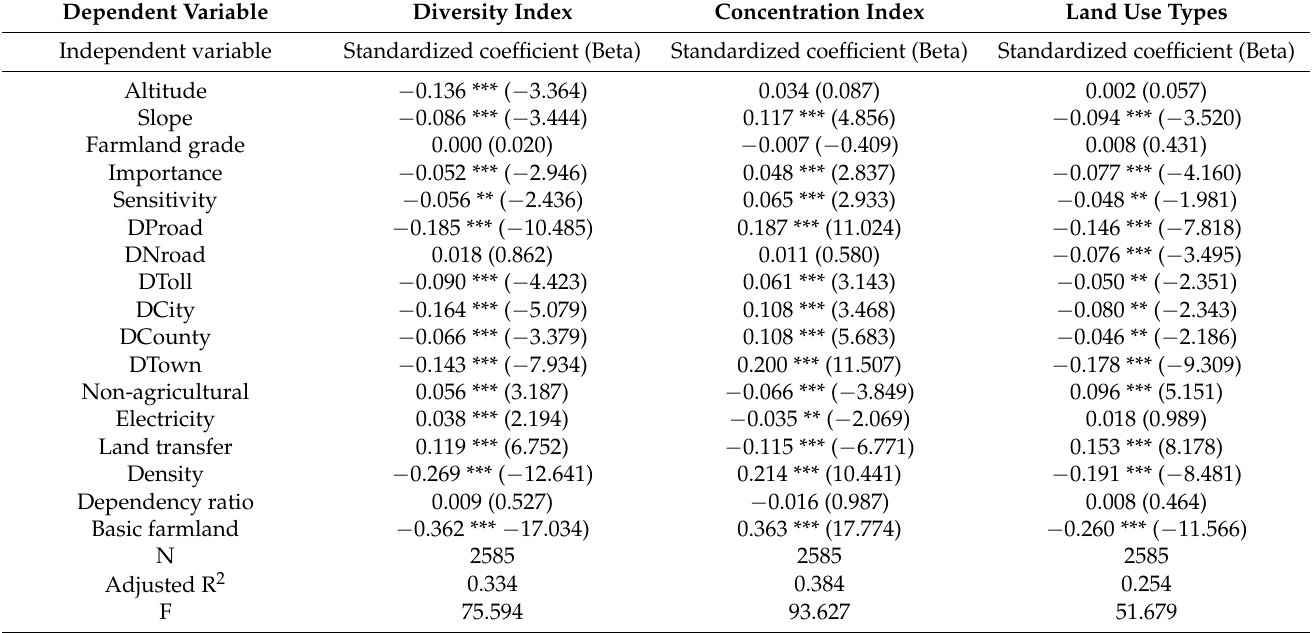
Table 4. Regression results.